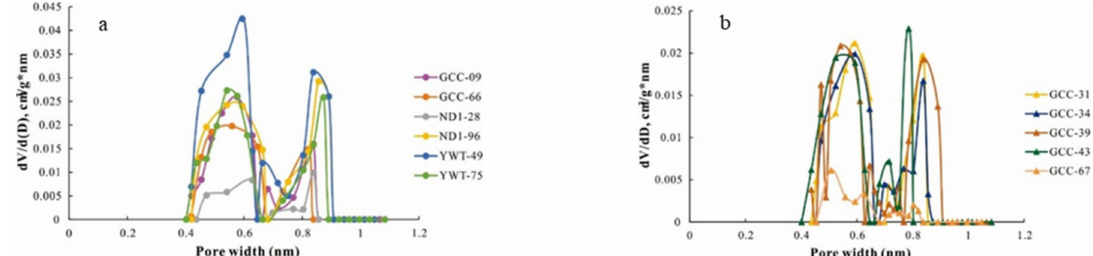
Figure 10. Micropore pore size distribution characteristics of siliceous shales ( a ) and argillaceous shales ( b ) in Niutitang